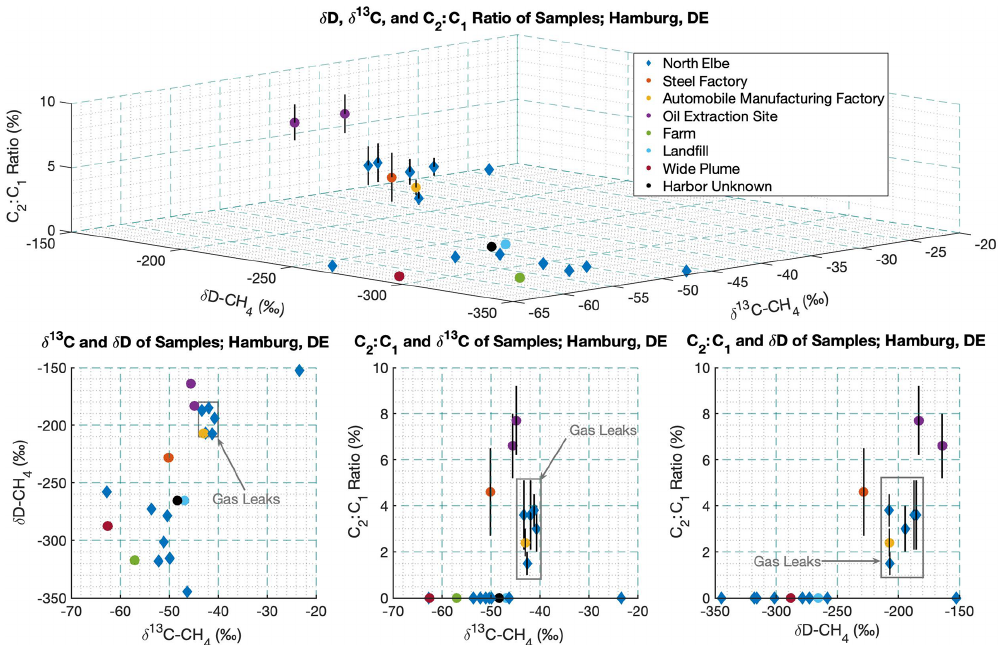
Figure 5. Results from the attribution measurements in Hamburg: C 2 : C 1 ratios and isotopic signatures ( δ 13 C and δ D) of collected air samples; measurement uncertainty in δ 13 C is 0.05‰–0.1‰ and in δ D